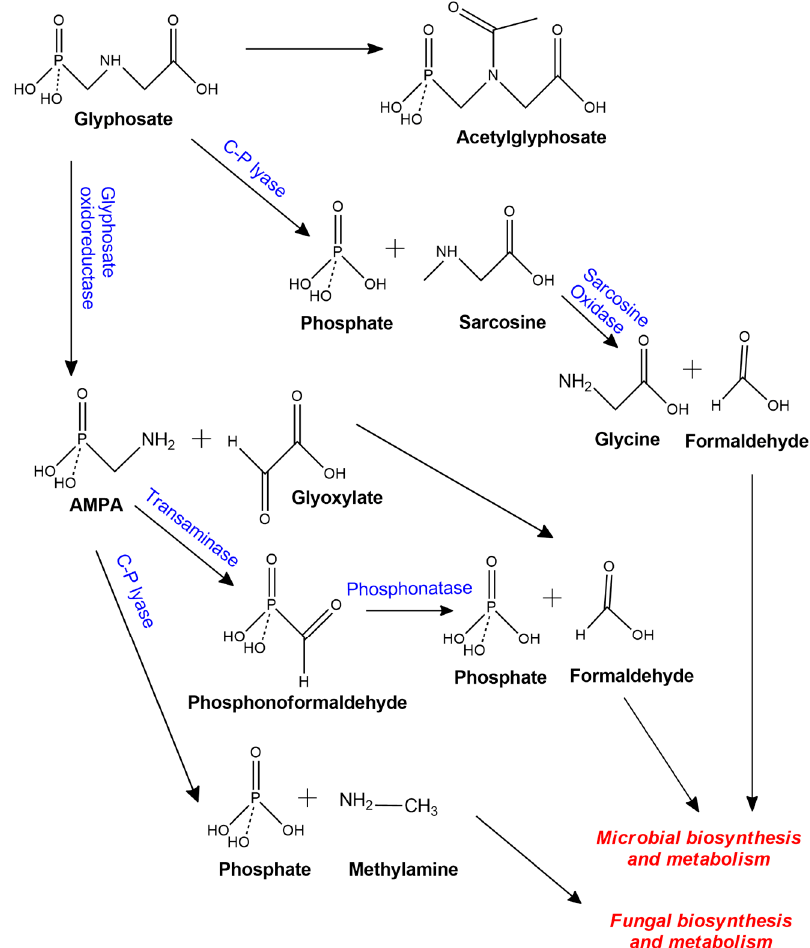
Figure 1. Degradation pathways of glyphosate in fungal and bacterial species [7,20,21].